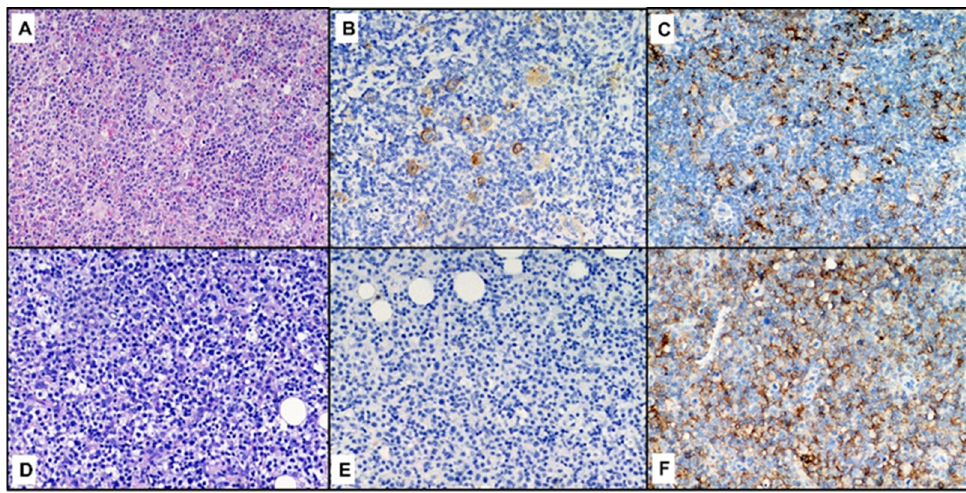
Figure 2. Histological comparison between cHL ( A – C ) and DLBCL ( D – F ) in the same patient (case n.3). In each row, from left to right, hematoxylin-eosin, CD30 and PD-L1 (original magnification 200 × ).